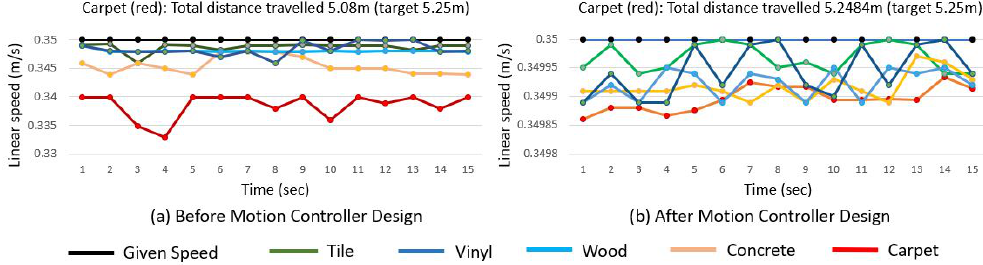
Figure 10. Snail robot’s traverse feedback before and after motion controller